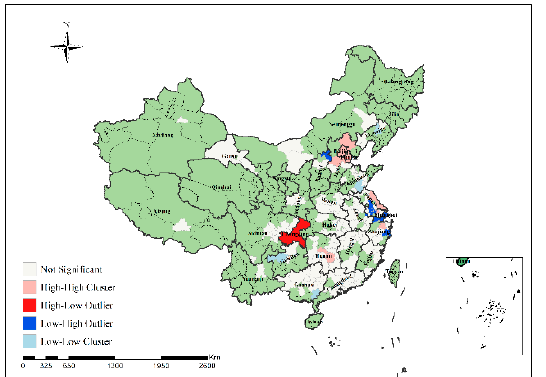
Figure 11. Local spatial autocorrelation analysis results of H7N9 outbreaks in China in 2017.